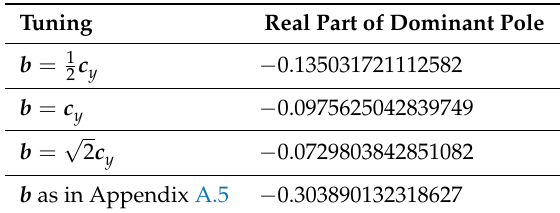
Table 2. Dominant poles for different tunings ( n =